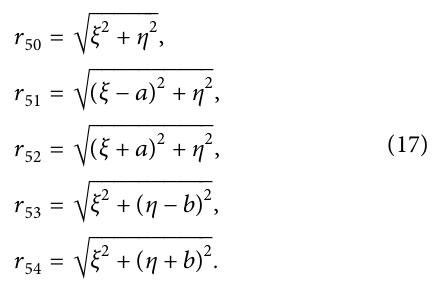
N 􏽥 both are negative (shaded region). m and m